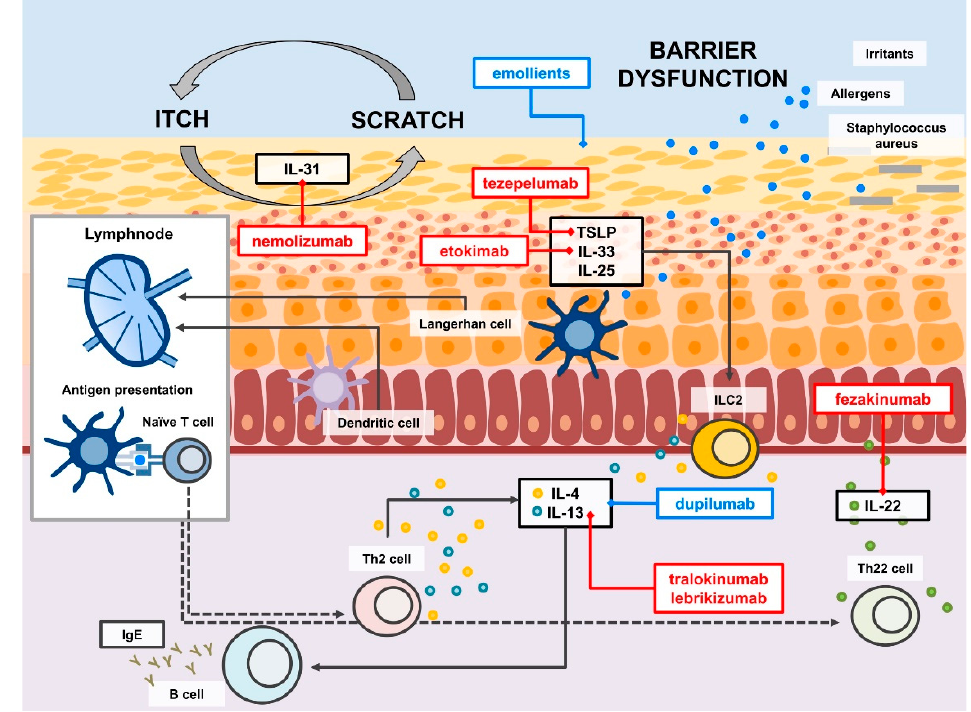
Figure 2. Main molecular pathways in atopic dermatitis targeted by emollients and biologicals. Approved available treatments are in blue boxes.